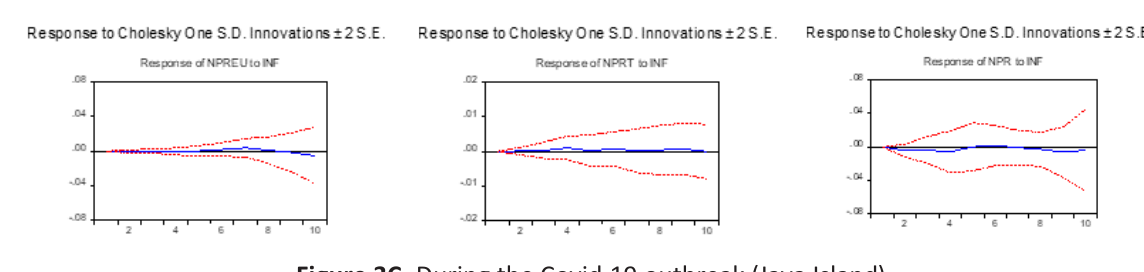
Figure 3C. During the Covid-19 outbreak (Java Island)